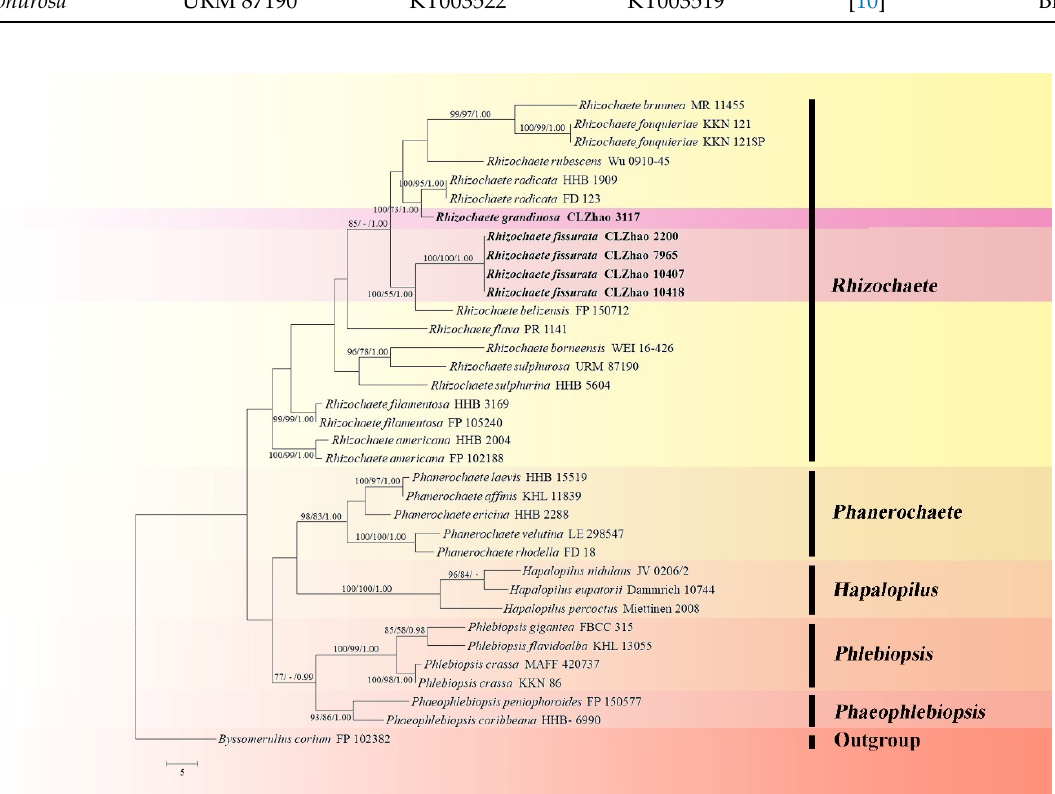
Figure 1. Maximum parsimony strict consensus tree illustrating the phylogeny of the two new species and related species within the family Phanerochaetaceae based on ITS+nLSU sequences. Branches are labeled with maximum likelihood bootstrap values > 70%, parsimony bootstrap values > 50%, and Bayesian posterior probabilities > 0.95, respectively. Maximum parsimony analysis was applied to the combined ITS+nLSU and ITS datasets. The approach followed the previous study by Zhao and Wu [16], and the tree construction procedure was performed in PAUP* version 4.0a169 (http://phylosolutions.com/paup-test/, accessed on 5 October 2021). All characters were equally weighted, and gaps were treated as missing data. Trees were inferred using the heuristic search option with TBR branch swapping and 1000 random sequence additions. Max-trees were set to 5000, branches of zero length were collapsed, and all parsimonious trees were saved. Clade robustness was assessed using bootstrap (BT) analysis with 1000 replicates [27]. Descriptive tree statistics—tree length (TL), consistency index (CI), retention index